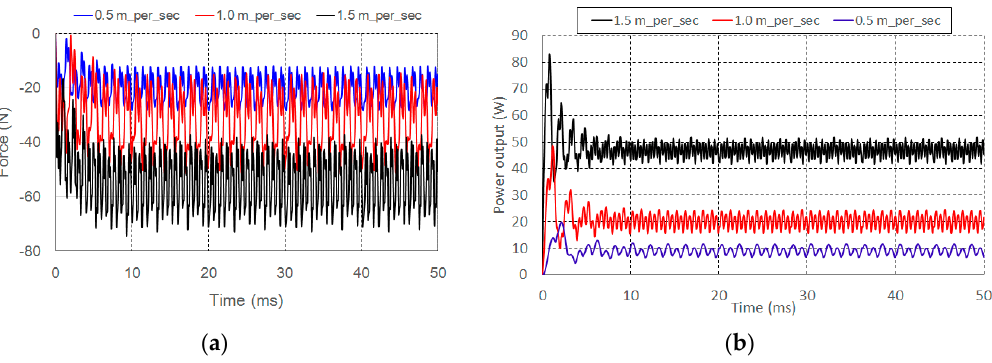
Figure 18. Analysis under various speeds ( a ) the electromagnetic forces and ( b ) power outputs.